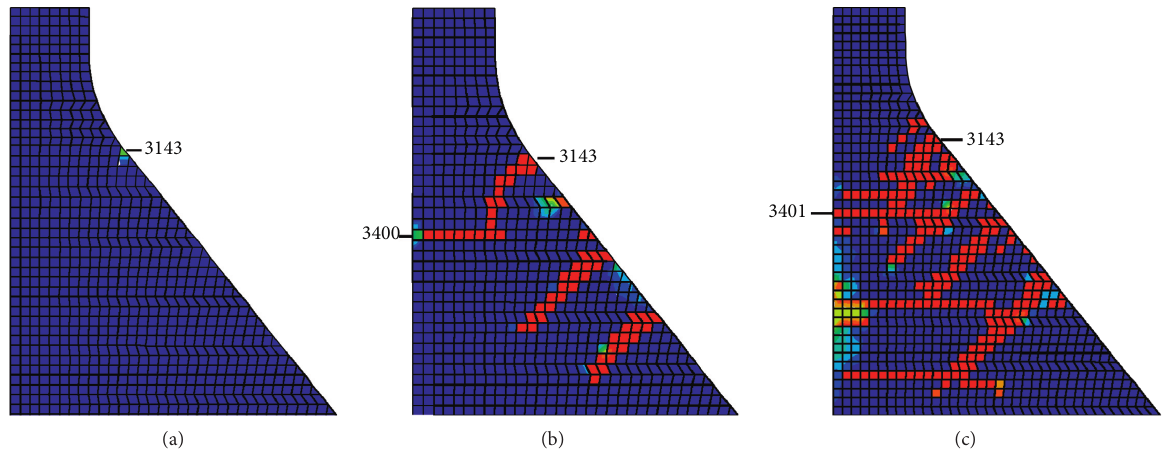
Figure 9: Number of damage elements of the dam head under different overload coefficients. (a) 1.2. (b) 1.53. (c)